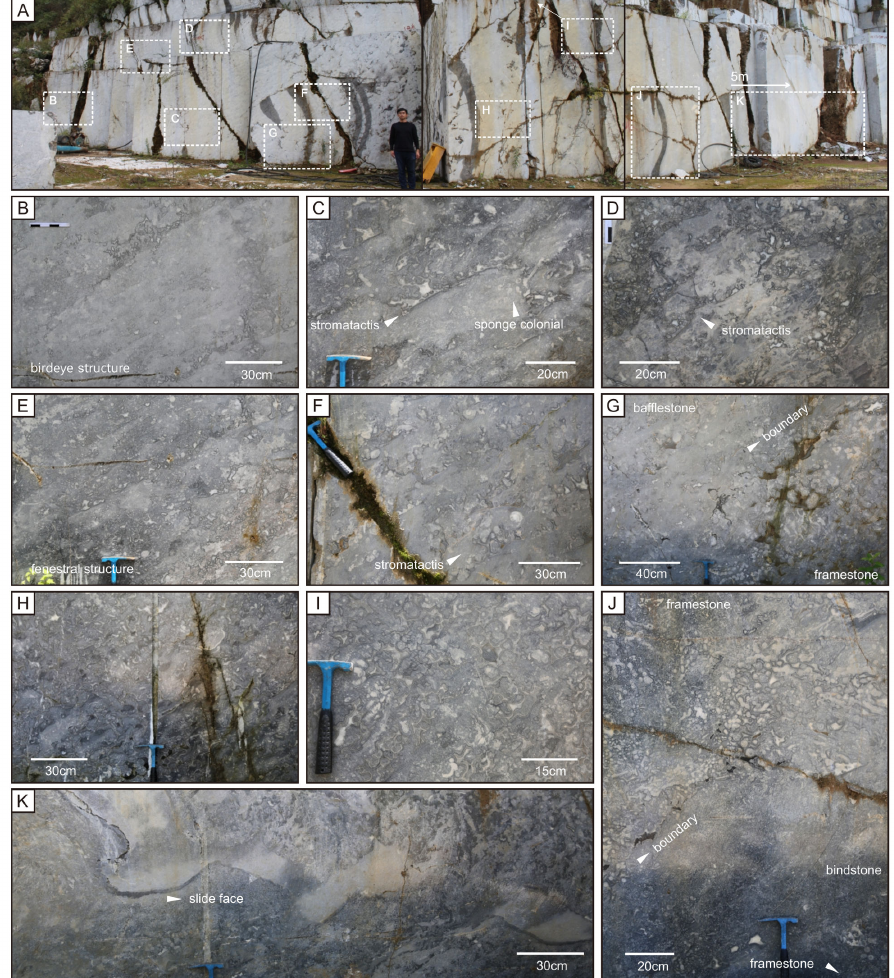
Figure 6. Images of the outcropping lithofacies: ( A ) profile includes photozoan reef core association and tide-controlled reef crest association of the reef; ( B , E ) benthic organisms bindstone with fenestral structure; ( C , D , F ) binding-skeleton sponge bafflestone with stromatactis. ( G ) sedimentary discontinuity face; the boundary between open-skeleton sponge framestone and open skeleton bafflestone. ( H ) binding-skeleton sponge framestone; ( I ) open-skeleton sponge framestone. ( J ) boundary (distal slide) of the framestone and bindstone. ( K ) slide structure inside the reef core; the boundary between the phase 2 and phase 3 of the